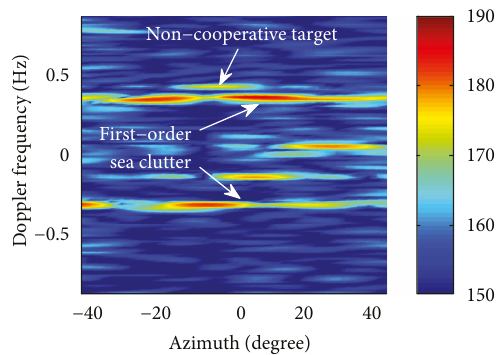
Figure 5: Azimuth-Doppler map of sea clutter and